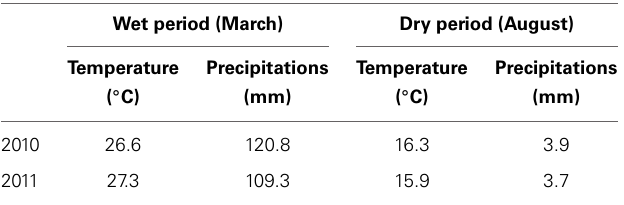
Table 2 | Precipitation (mm) and temperature ( ◦ C) values, during dry (March) and wet (August)